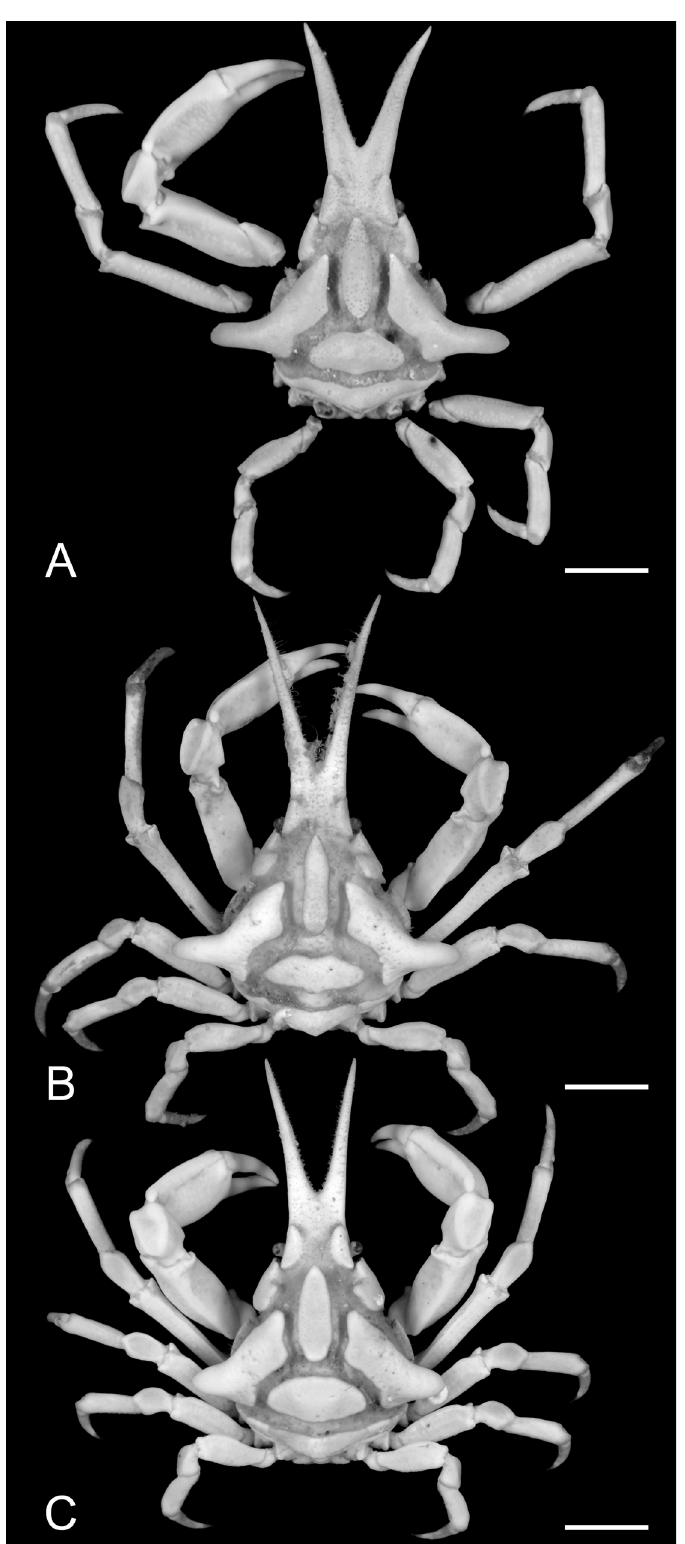
Fig. 2. Oxypleurodon stimpsoni Miers, 1885, overall dorsal view. A . ♂ (14.0 × 9.0 mm) (AM P34658), Indonesia. B . ♂ (14.9 × 10.2 mm) (ZRC 2011.0056), Philippines. C . ♂ (with Sacculina , 14.0 × 9.0 mm) (ZRC 2016.0072), South China Sea. Scale bar = 5